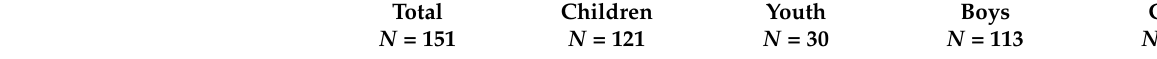
Table 3. Parent-reported changes in movement and play behaviours of children (5–13 years) and youth (14–17 years) during the acute phase (May 2020) of the COVID-19 pandemic ( N =